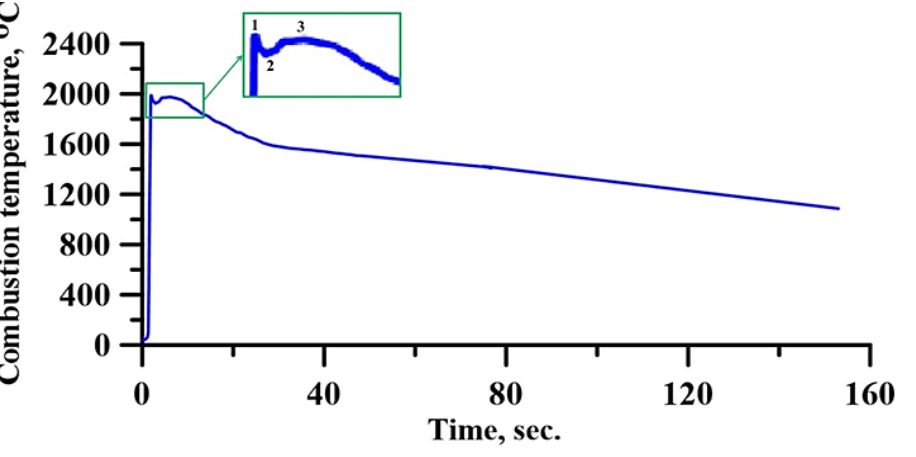
Figure 3. Thermogram of the synthesis of CrN-TiNi samples taking place at the argon pressure of 3